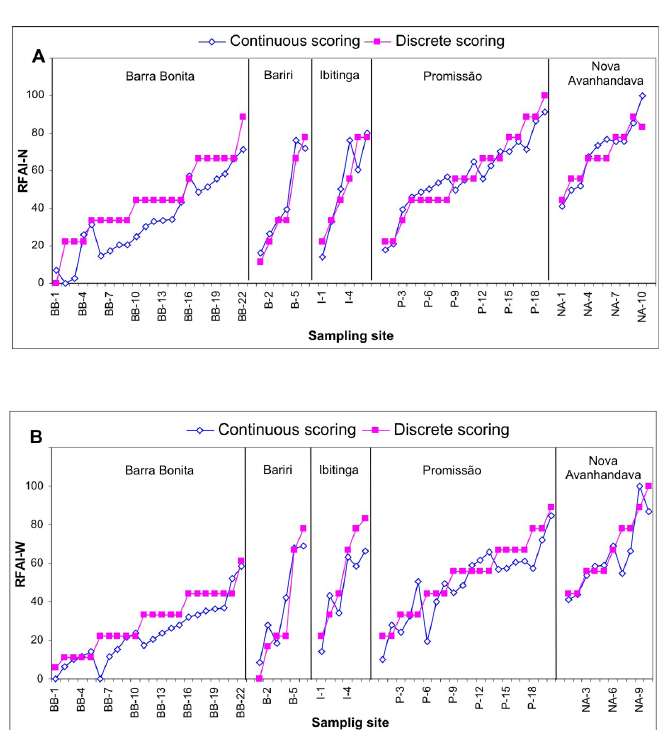
Figure 5. Comparison between standardized continuous and discrete scoring for RFAI-N (A) and RFAI-W